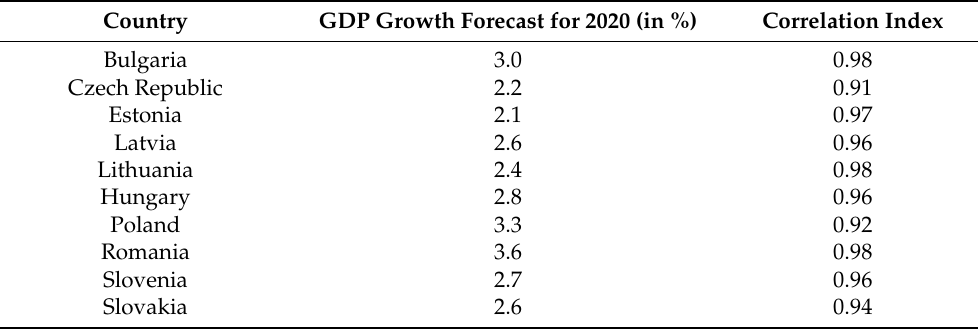
Table 2. European Commission Autumn 2019 forecast of economic growth in 2020 and the results of the correlation between turnover value in tourism sector and gross domestic product at market prices in 2008–2019 in Central and Eastern European countries.